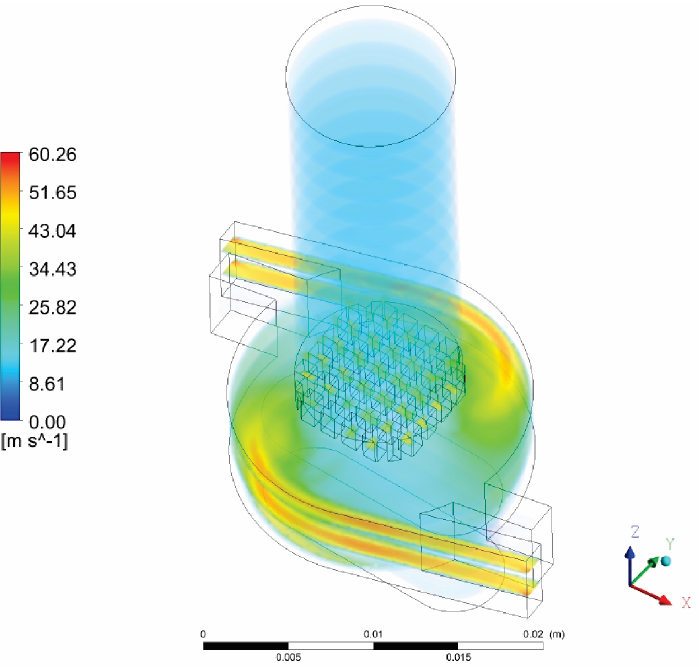
Figure 5. Fluid velocity magnitude in 3D model.